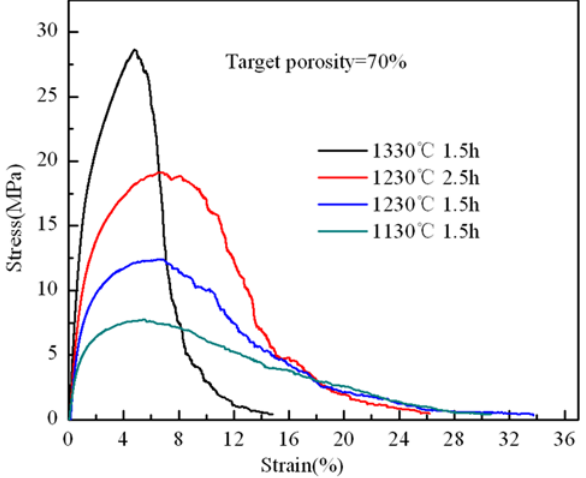
Figure 6. Uniaxial tensile stress-strain curves of the stainless steel PTWMs with 70% target porosity under the different sintering process. Table 1. Summary of the tensile properties of the PTWMs with different sintering parameters. Target Porosity after Ultimate Tensile Elongation at Elongation at Sintering Parameters Porosity (%) Sintering (%) Strength (MPa) F-max (%) Total Failure